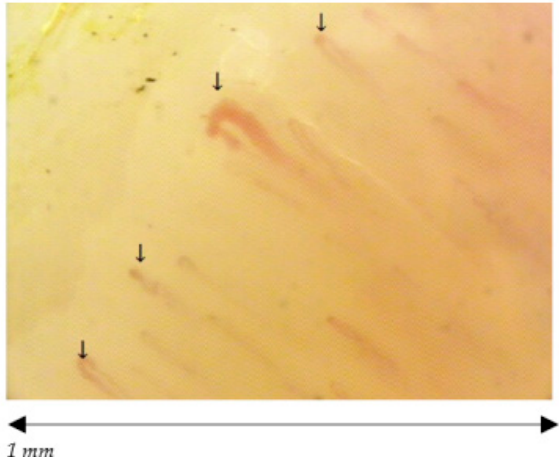
Figure 3. Male aspecific pattern; reduced density of capillaries ( ↓ ).